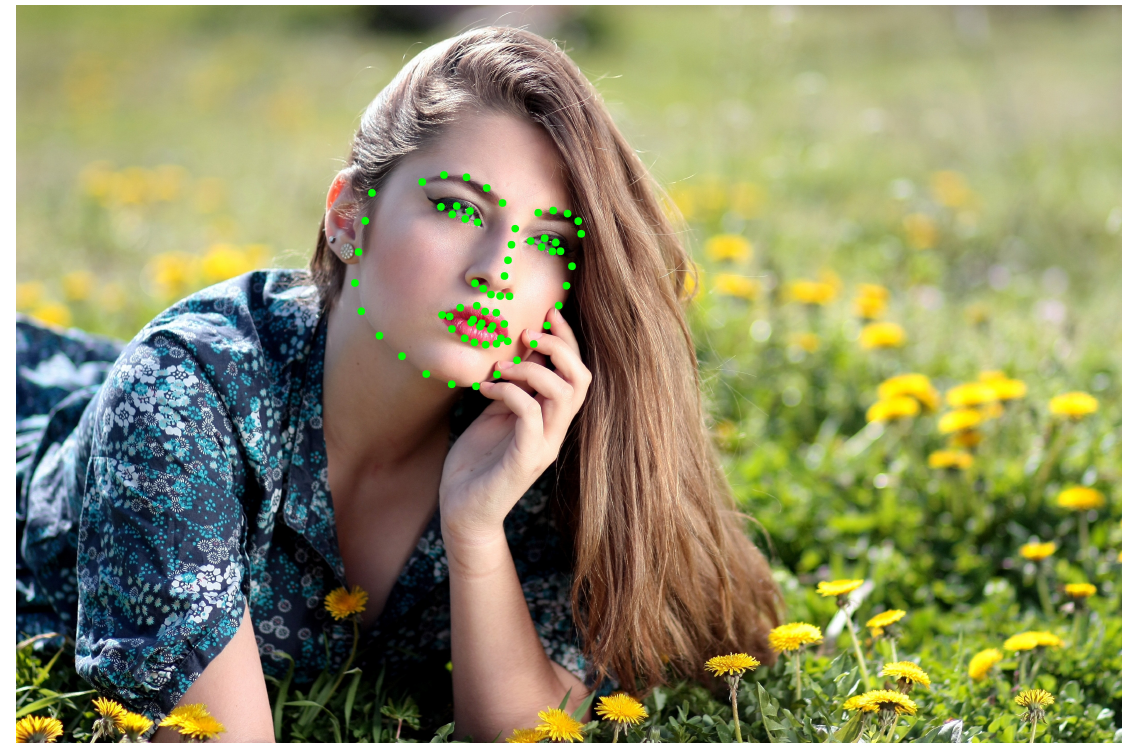
Figure 1. Sample image with predicted facial landmarks. An ensemble of randomized regression trees is used to detect 194 landmarks on a face from a single image